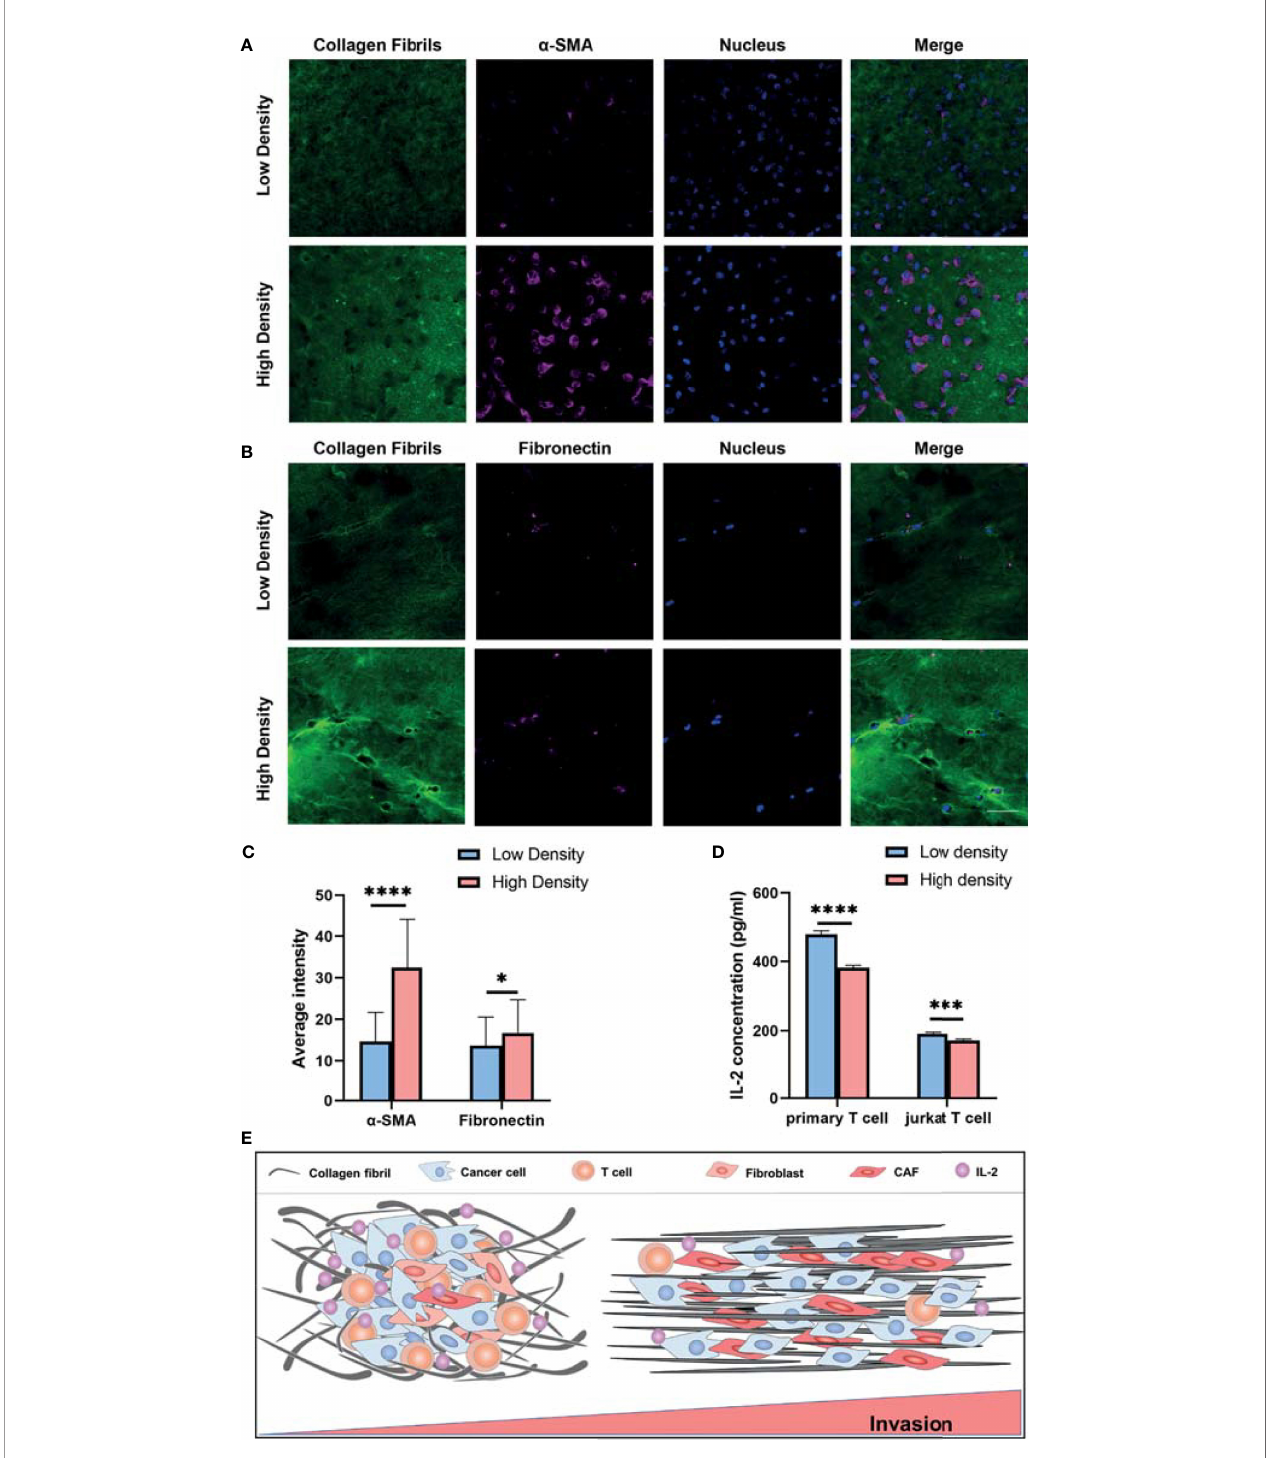
FIGURE 7 | Collagen density modulates the CAF induction and T cell activation. (A) Immuno fl uorescence staining of a -SMA of MRC-5 cells encapsulated in low and high density of collagen fi brils. (B) Immuno fl uorescence staining of fi bronectin of MRC-5 cells encapsulated in low and high density of collagen fi brils. (C) Average fl uorescence intensity of a -SMA and fi bronectin between different collagen density groups. (D) IL-2 levels of activated primary T cells and Jurkat T cells encapsulated in low and high density collagen fi brils. (E) High invasive breast cancer subtypes exhibit increased ECM density and alignment consistency, which promotes tumor invasion due to immunosuppression of T cells as well as CAF activation. ns, not signi fi cant; (scale bar, 50 m m). * P < 0.05; *** P < 0.001, **** P <